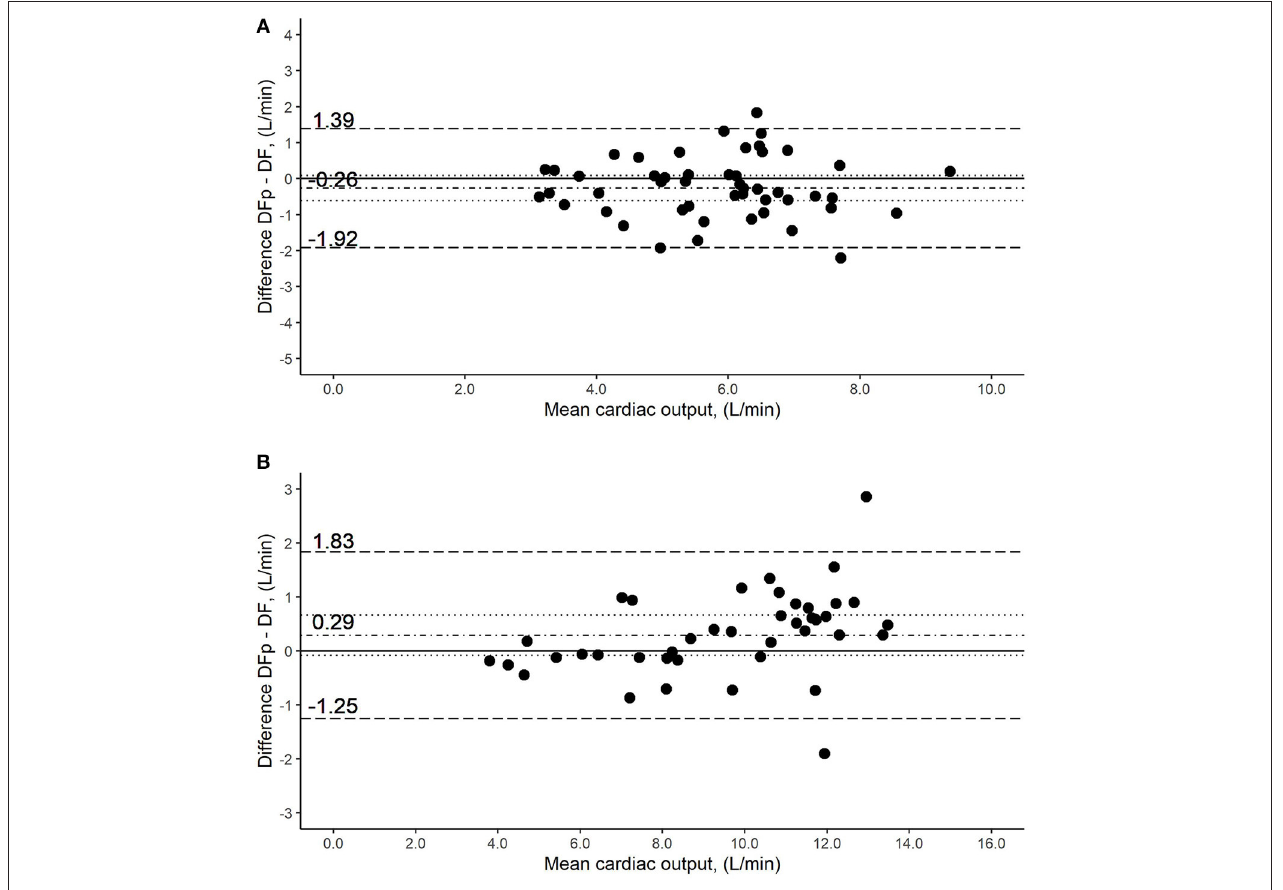
FIGURE 3 | Bland-Altman plot of the comparison of cardiac output (CO) measurement methods by direct Fick using pulse oximetry (DFp) vs. direct Fick using blood gases (DF). Y -axis was calculated as the mean of the two methods being compared. The solid line represents no difference in the means by the two methods. The dot-dashed line around zero represents the measured difference of the means, while the dotted lines stand for the 95% CI. The broken lines above and under it, represent the limits of agreements. (A) Measurements at rest: the difference in the means (bias) was − 0.26 L/min (95% CI, − 0.62 to 0.09 L/min), with the lower and upper limits of the agreement being − 1.92 and 1.39 L/min, respectively. (B) Measurements at end-exercise: bias was 0.29 L/min (95% CI, − 0.08 to 0.67 L/min), with the lower and upper limits of the agreement being − 1.25 and 1.83 L/min,